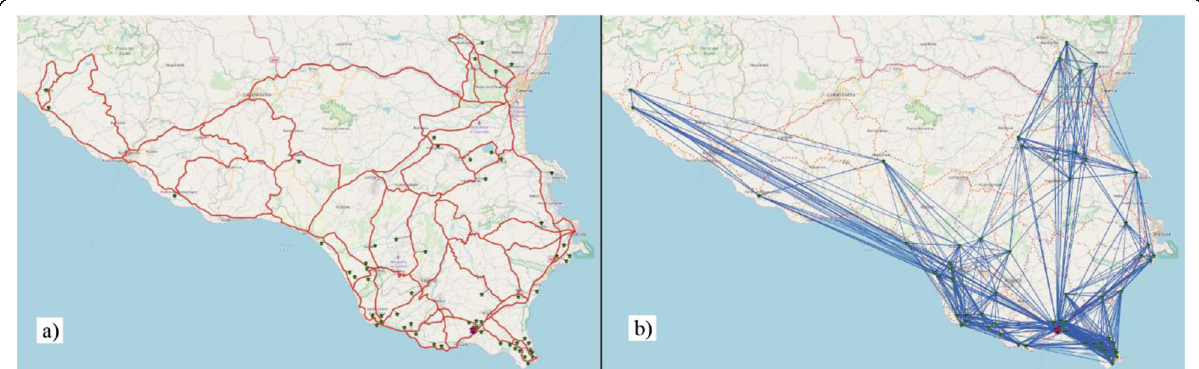
Fig. 4 Road network graph implemented in NetLogo; a Base layer; b Upper